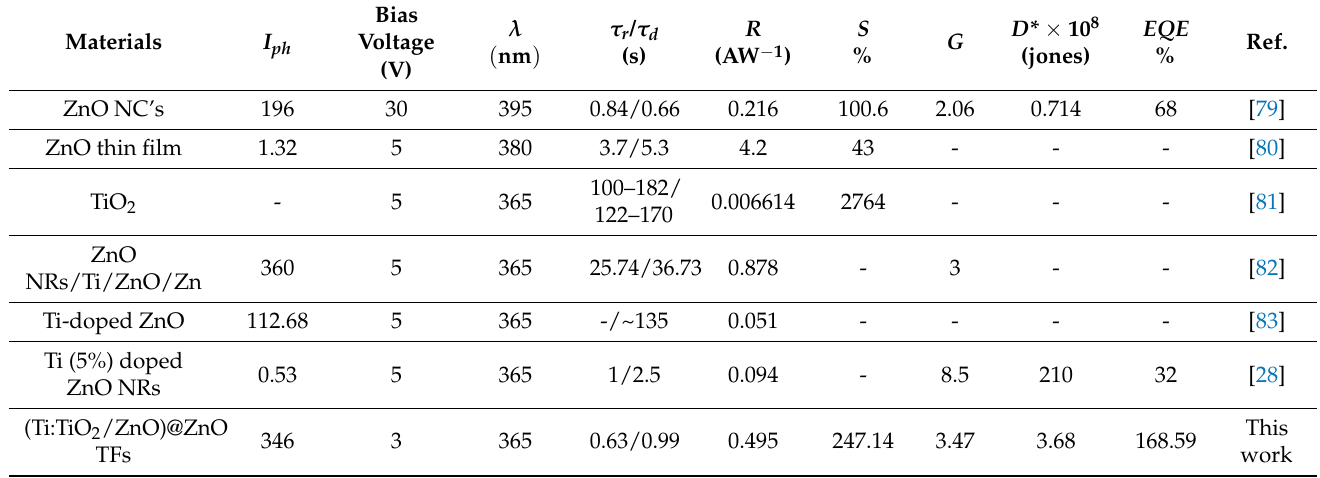
Table 6. Comparison of electrical parameters of photodetectors reported in the literature and the best result obtained from this